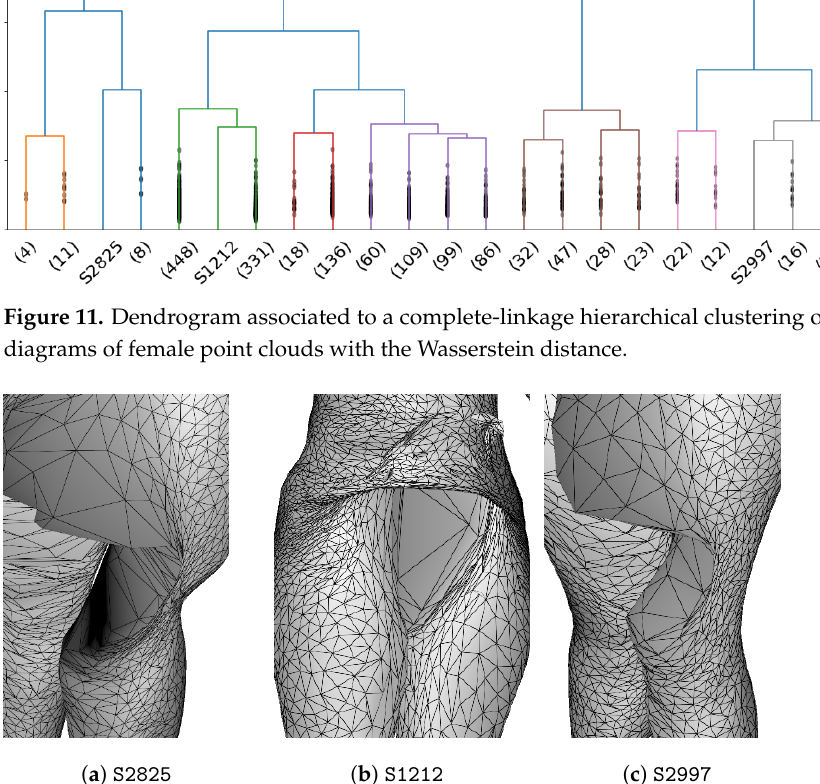
Figure 12. Anomalies of female scans detected by complete-linkage hierarchical clustering of persis- tence